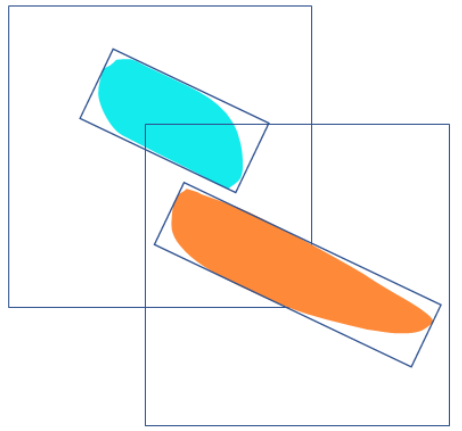
Figure 4. SegDetector calculates the BCE loss in separate channels and generates the final detection frame in separate channels to reduce the difficulty of detecting obscured targets.